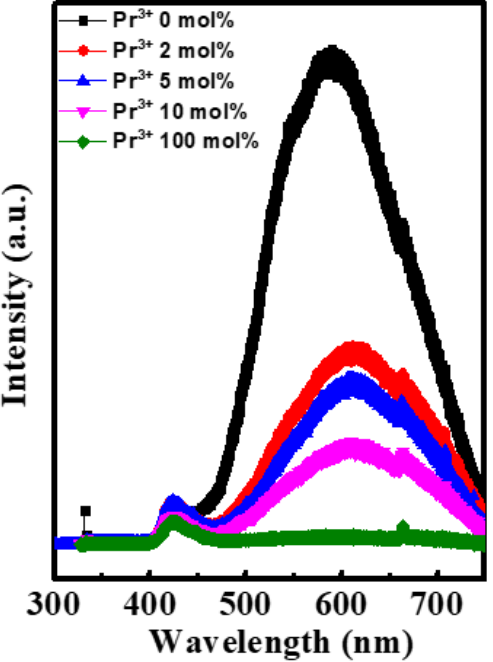
Figure 5. ( a ) Transmittance spectra and ( b ) evaluation of optical bandgap for In-Pr-O layer with different Pr ratios.